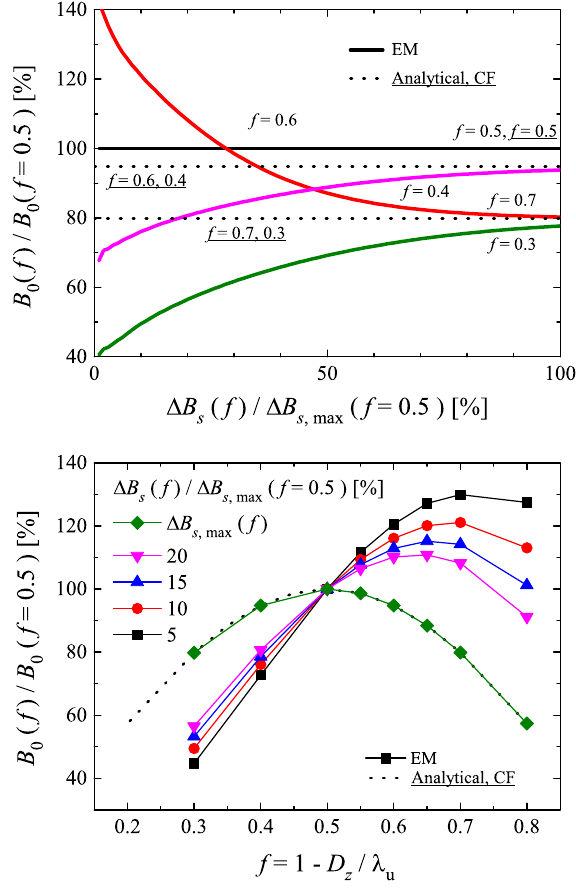
FIG. 6. Dependence of B 0 on f (analytical, CF, and EM, ¼ 0 . 4 ). For comparison, the analytical (numerical) fields g= λ u at various f are normalized by the analytical (numerical) value for f ¼ 0 . 5